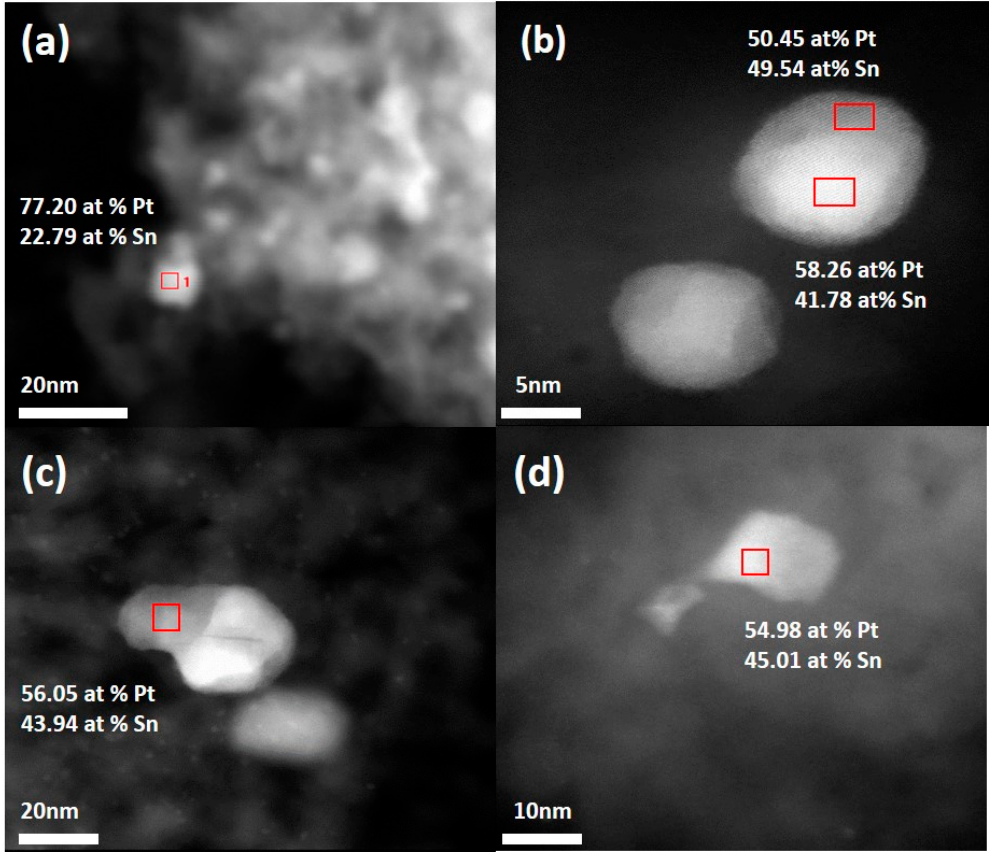
Figure 6. EDS analysis of ( a , b ) SR550 and ( c , d ) Cal600.